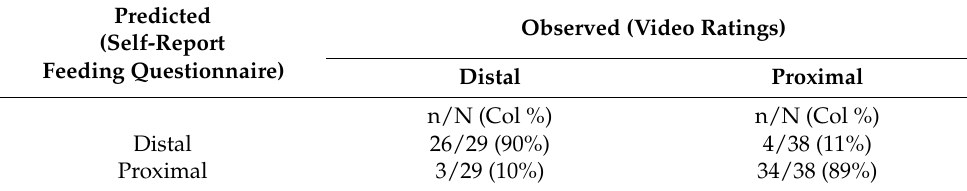
Table 4. Number and Percentage of Mother-Infant Dyads by Observed and Predicted Distal and Proximal